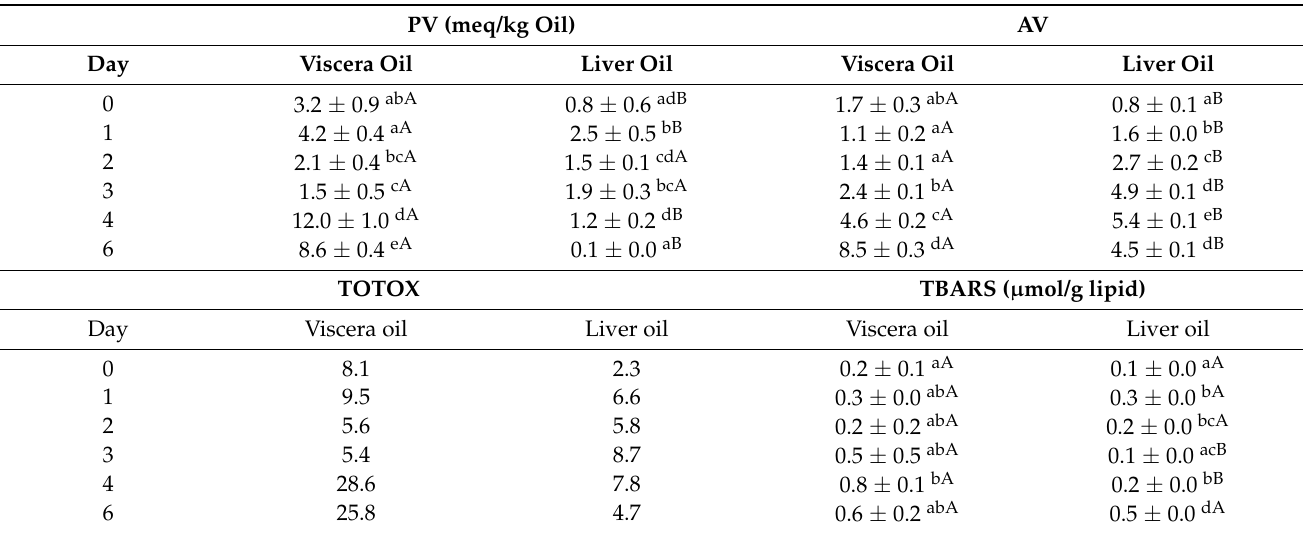
Table 3. PV (meg/kg oil), AV, TOTOX and TBARS ( µ mol/g lipid) values in oil produced from viscera and liver at different storage times (mean ±